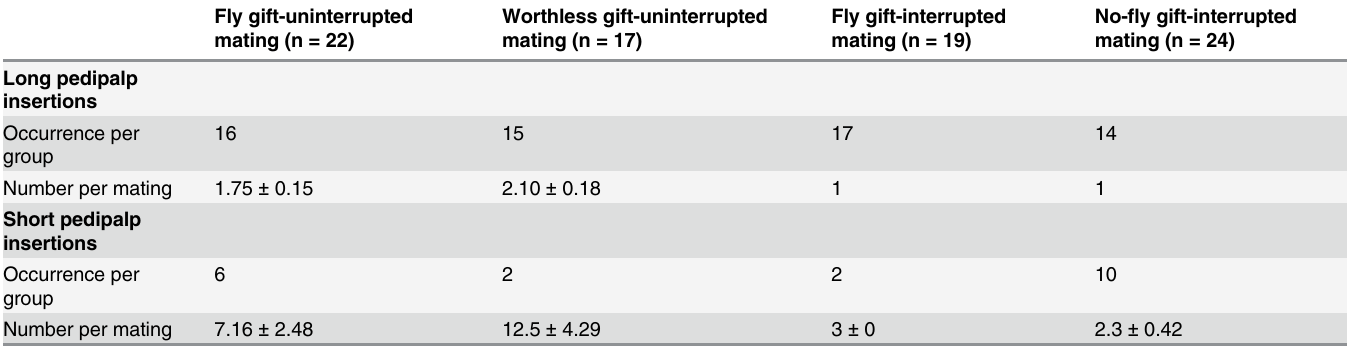
Table 2. Occurrence and average number of long and short pedipalp insertions in Fly gift-uninterrupted mating, Worthless gift-uniterrupted mat- ing, Fly gift-interrupted mating, No-fly gift-interrupted